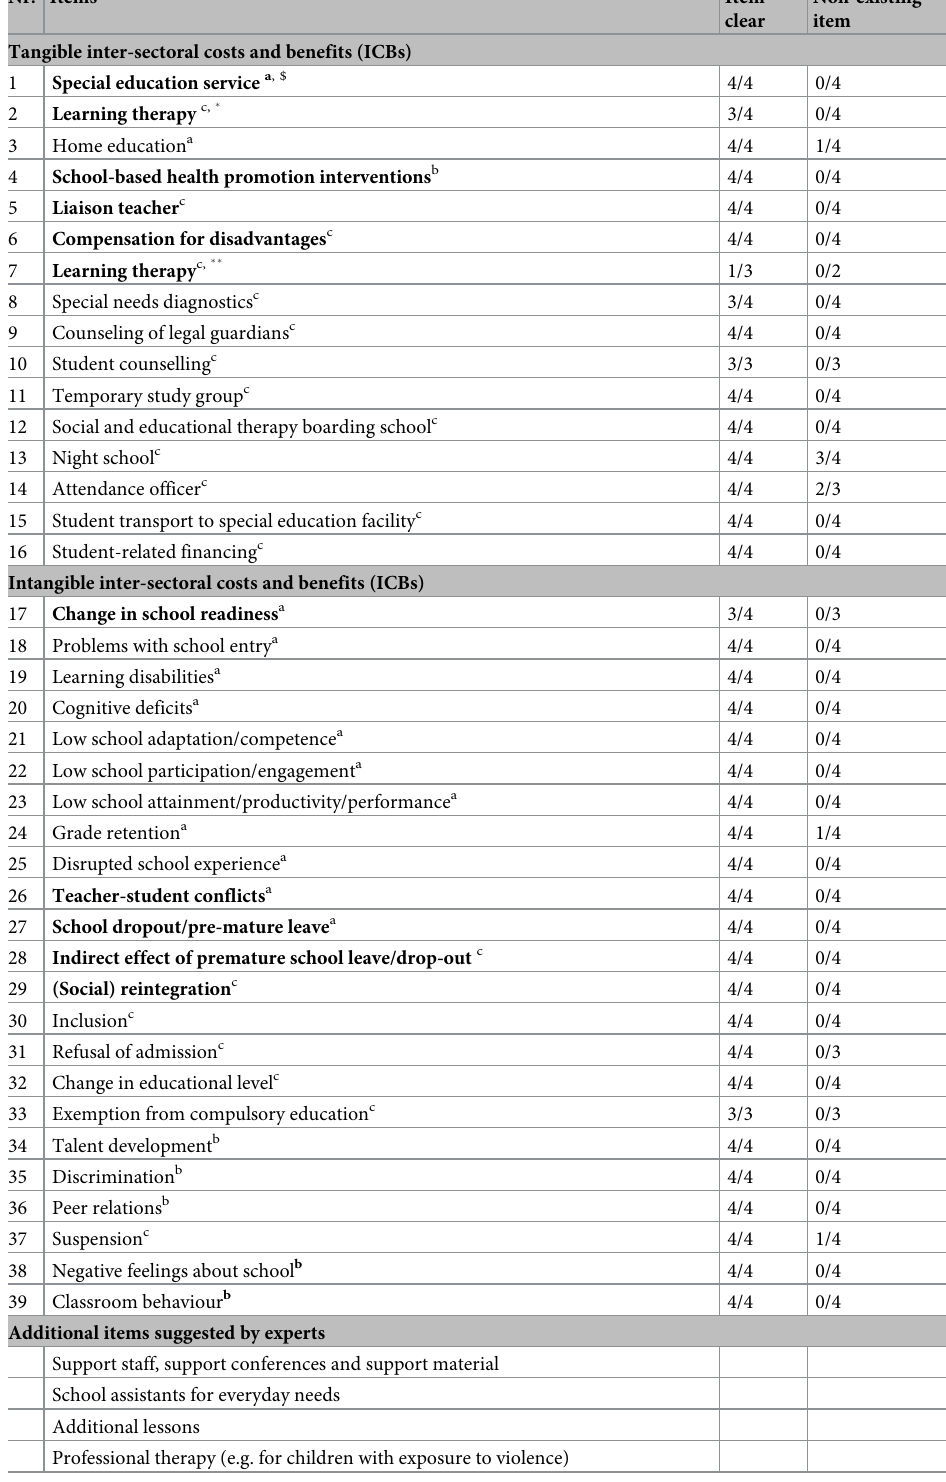
Table 4. Characteristics of items in the education (ED) sector list, Austrian survey. Nr.